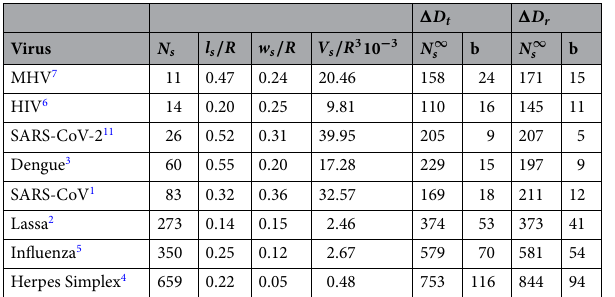
Table 2. Summary of characteristic N s , l s , w s , and surface protein volume V s / R with the fitted parameters N ∞ s ( ± 2 ) and b ( ± 2 for (cid:31) D t and ± 3 for (cid:31) D r ) from (1). All the parameters obtained from fitting of (1) lead to a determination coefficient R 2 d = 0.99